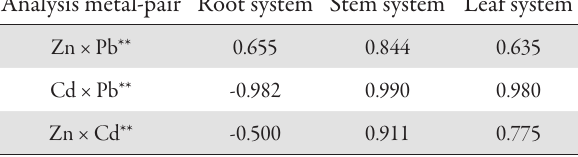
Tab. 4. Pearson correlation coefficient between concentrations of heavy metal pairs in root, stem and leaf systems of A. marina Analysis metal-pair Root system Stem system Leaf